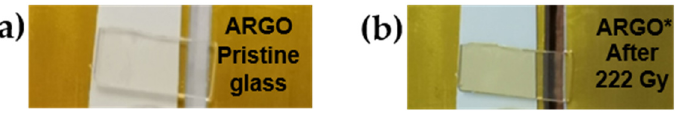
Figure 2. ( a ) Transparent color before irradiation (ARGO glass sample), ( b ) yellow color after X-ray irradiation with 222 Gy (ARGO* glass sample).